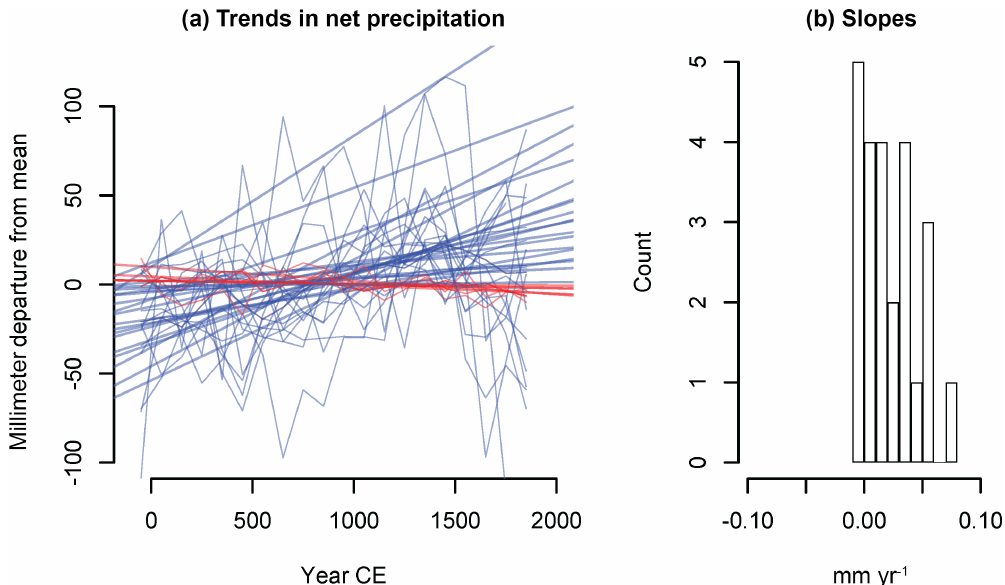
Figure 8. Time series and trends of all quantitative records presented as millimeter departures from their mean over the Common Era. Net precipitation is used here to include pollen-inferred annual precipitation, precipitation minus evapotranspiration changes estimated from lake levels, and ice core accumulation rates (calibrated records in Table 1). Blue time series indicate those with positive linear trends from 1 to 1500CE; red time series have negative linear trends. Trend lines in (a) were fit using generalized linear models with a first-order autoregressive term. The slopes of the models appear as a histogram in (b)